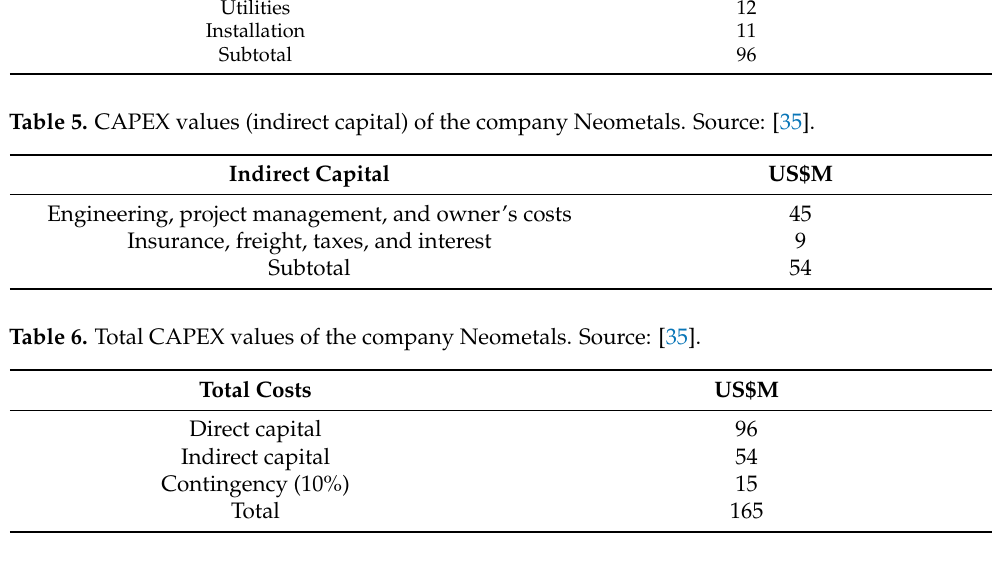
1 Negative values indicate that recyclers are paid to recycle batteries.